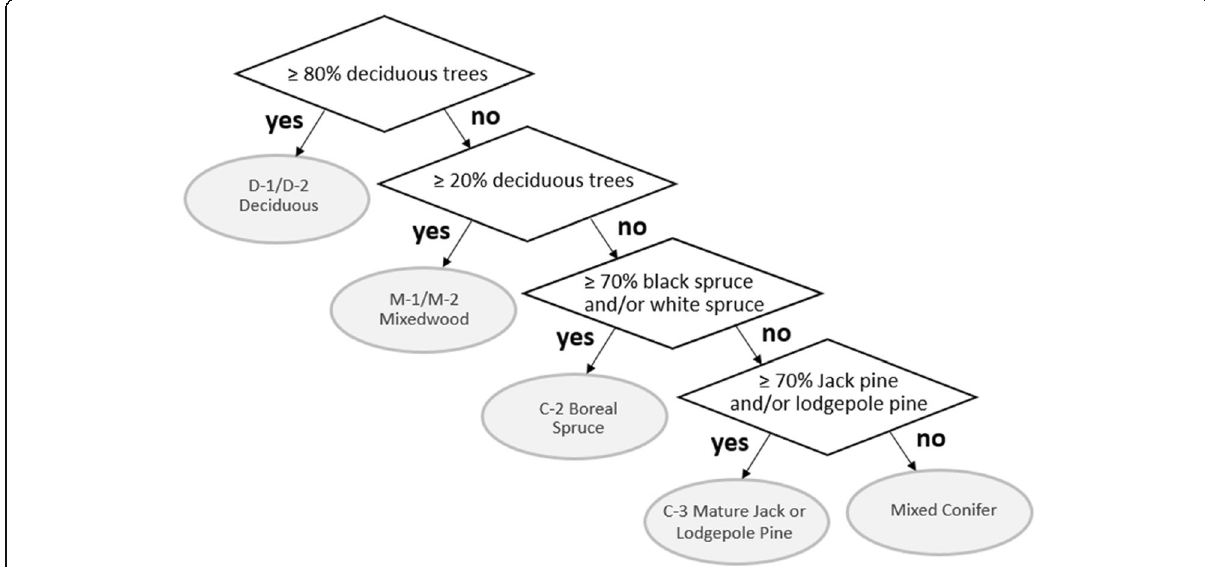
Fig. 3 A diagram outlining how each sampling event was assigned one of four Forest Fire Behaviour Prediction (FBP) System fuel types (Forestry Canada Fire Danger Group 1992) or alternately, if none were applicable, classified as Mixed Conifer. Deciduous trees included narrow-leaf cottonwood ( Populus angustifolia ), trembling aspen ( Populus tremuloides ), white birch ( Betula papyrifera ), balsam poplar ( Populus balsamifera ), and willow ( Salix